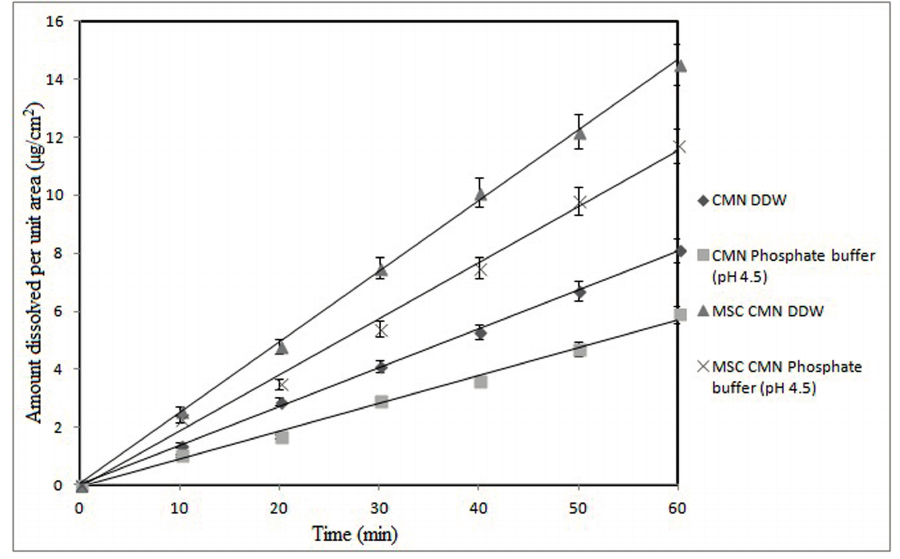
Figure 2. Intrinsic dissolution rate profile of CMN and MSC CMN in different dissolution